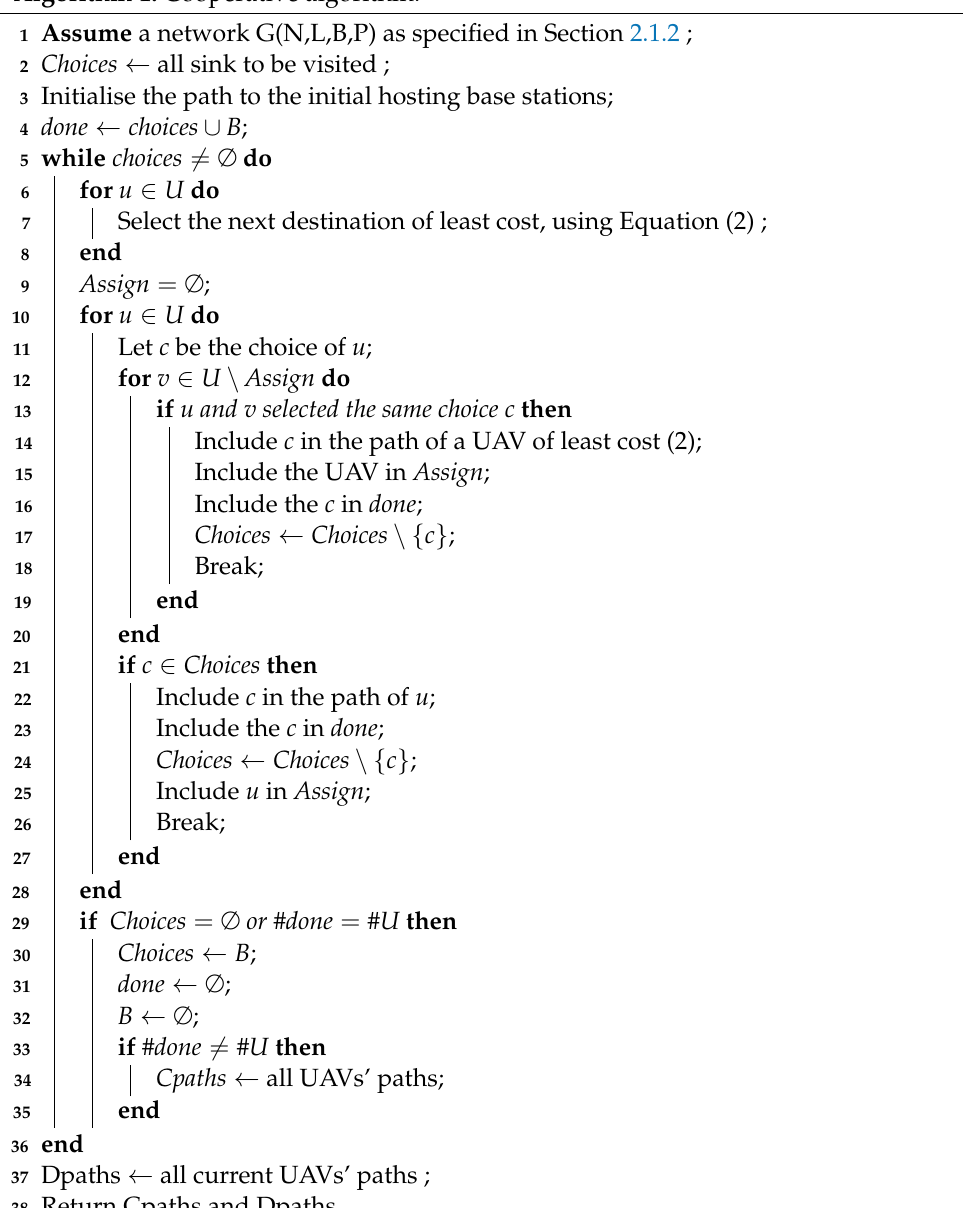
Algorithm 1: Cooperative